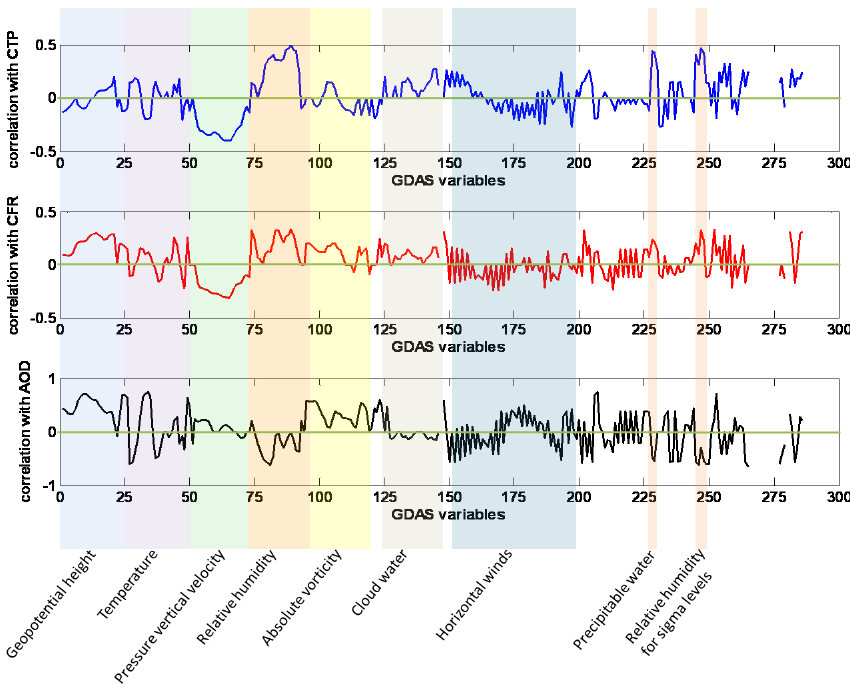
Fig. 9. Correlations between MODIS cloud top pressure (upper), cloud fraction (middle) and aerosol optical depth (lower) and the GDAS assimilation outputs for 1 ◦ spatial resolution. The zero correlation data points are those variables that did not pass the p-value < 0.01 test.